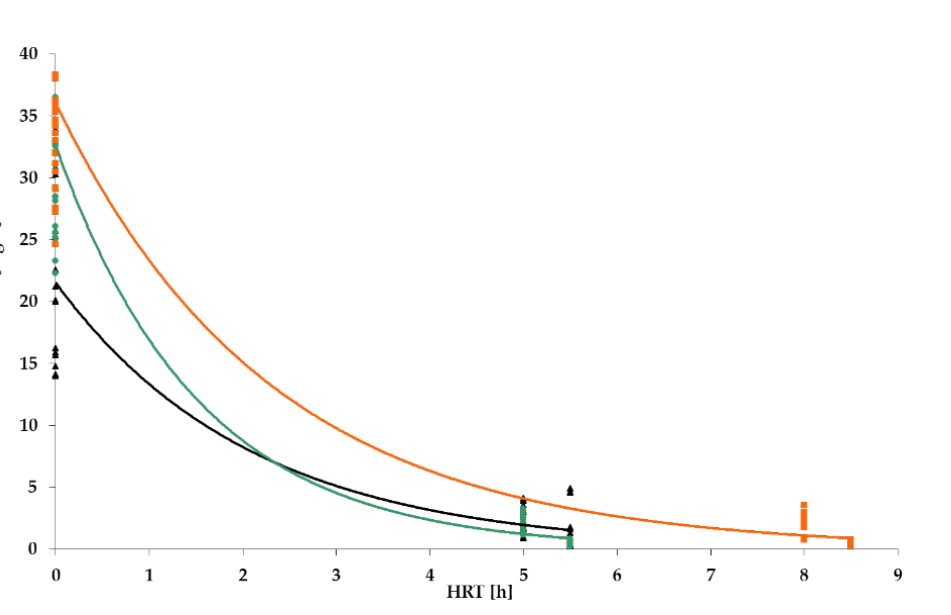
Figure 19. NH 4 removal dynamics: stage 1 (black); stage 2 (green); stage 3 (orange).